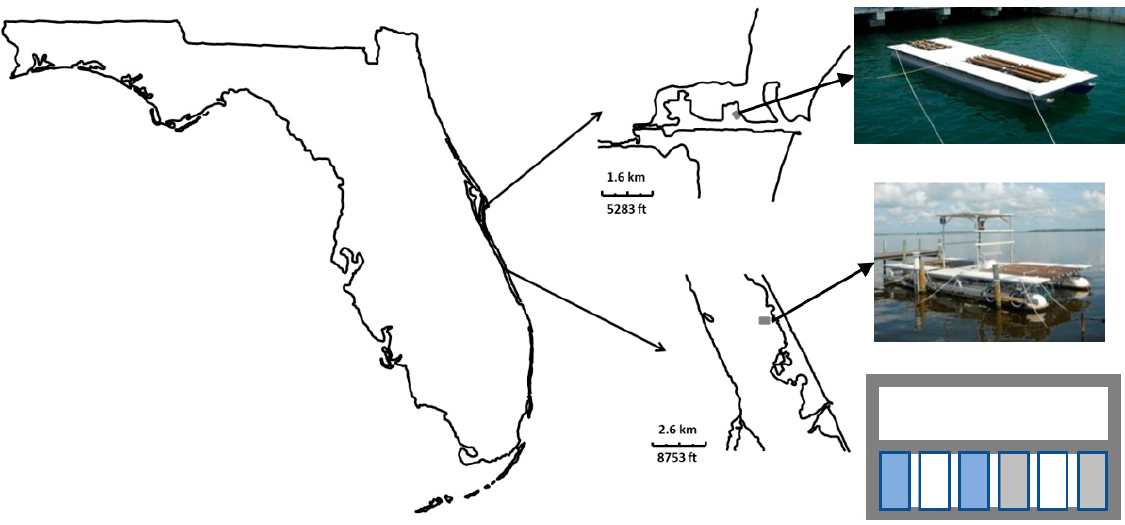
Figure 1. Map showing the location of the study sites, the two test barges and a diagram of the frame layout. Panels are suspended horizontally on PVC frames and suspended on the test barges.